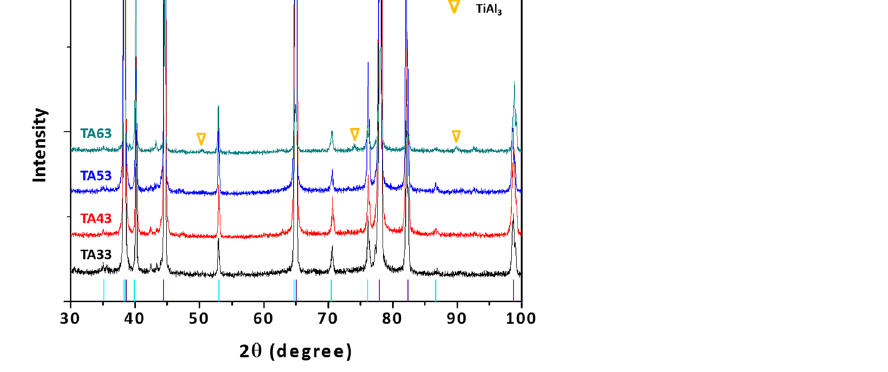
Figure 3. Existence of interfacial reaction layer (TiAl 3 ) in 600 °C-annealed specimen. X-ray diffraction peaks of the TA33, TA43, TA53, and TA63 specimens. In the TA63 specimen, peaks of a reaction product, i.e ., TiAl 3 , are formed, whereas they are not found in TA33, TA43, and TA53